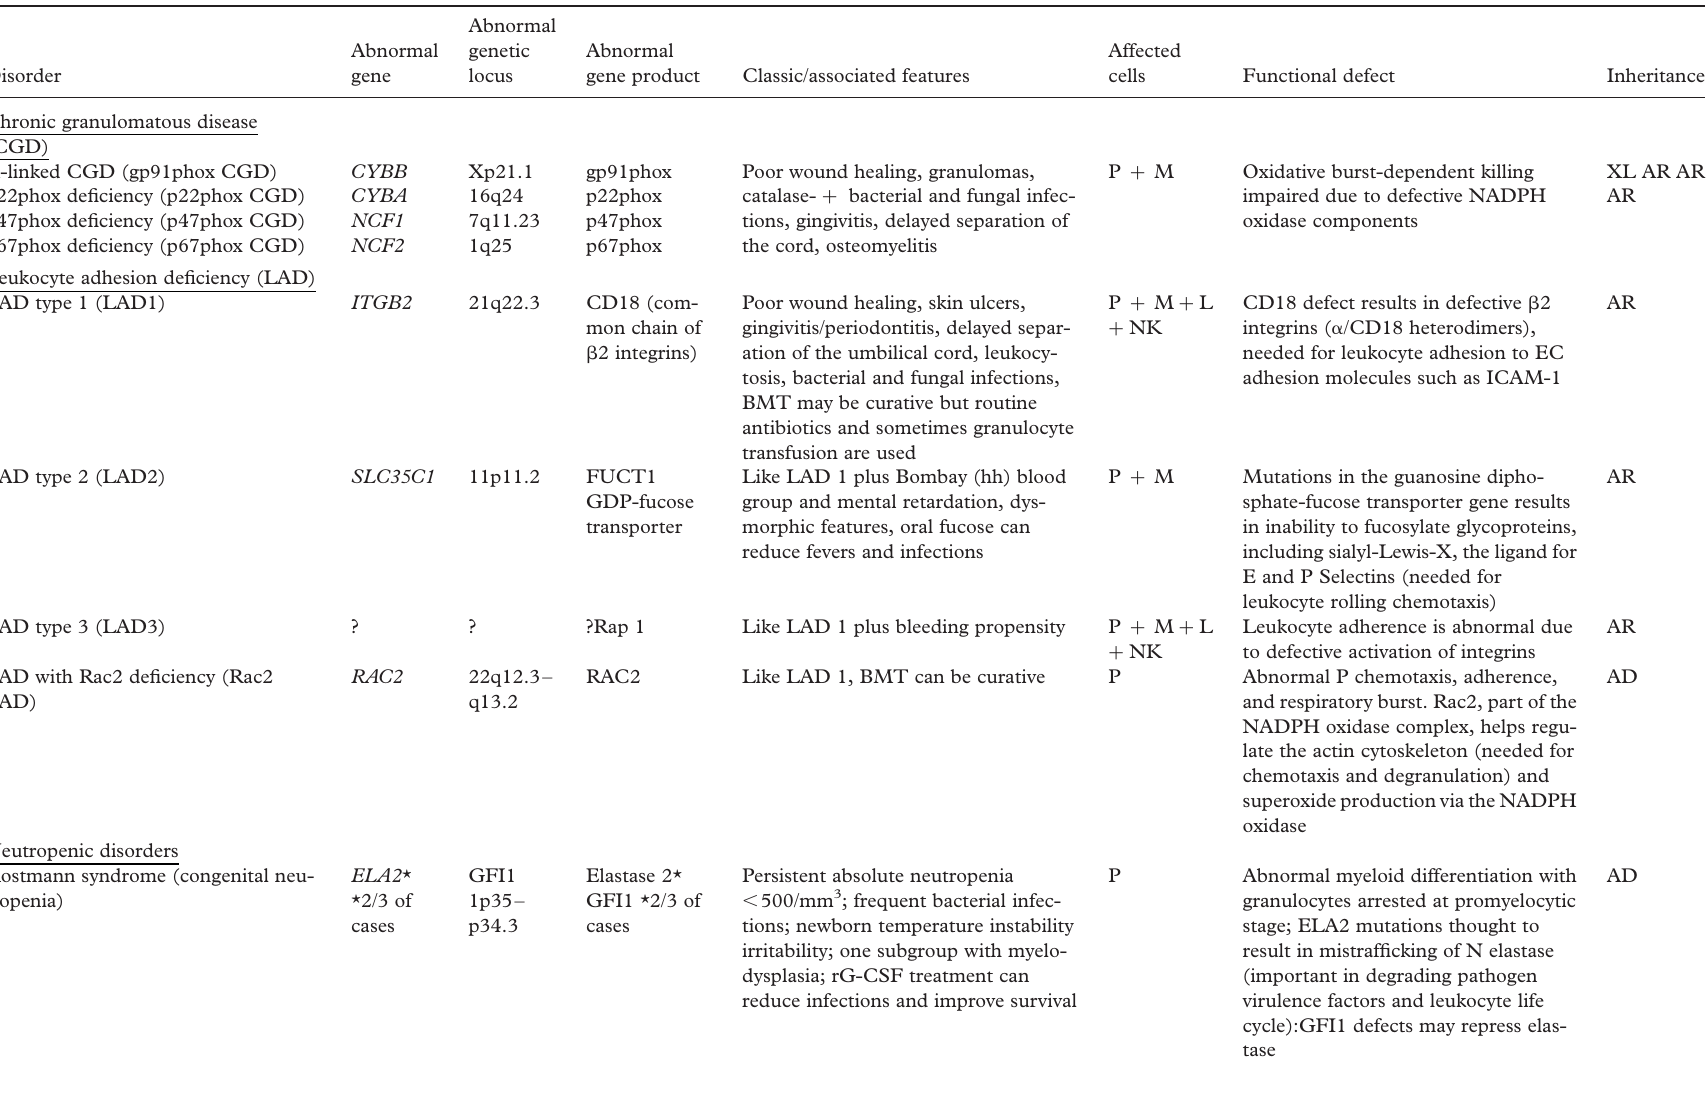
Table V. Phagocyte